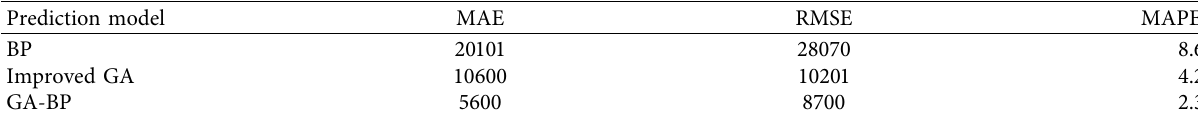
Figure 7: Comparison of sales forecast results and actual values based on BP neural network. Table 2: Prediction performances of three types of the prediction model.